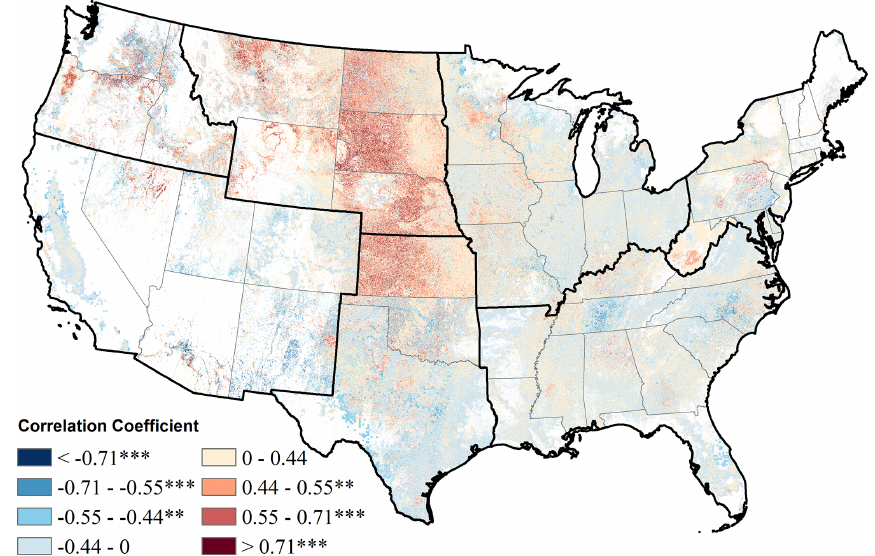
Figure 10. Correlation coefficient between annual NH 3 emission from N fertilizer uses and annual NH + between 1985 and 2015. The correlation coefficient was calculated between the two time series at each 1km × 1km grid cell. ∗∗ refers to p value < 0.01; ∗∗∗ refers to P value <